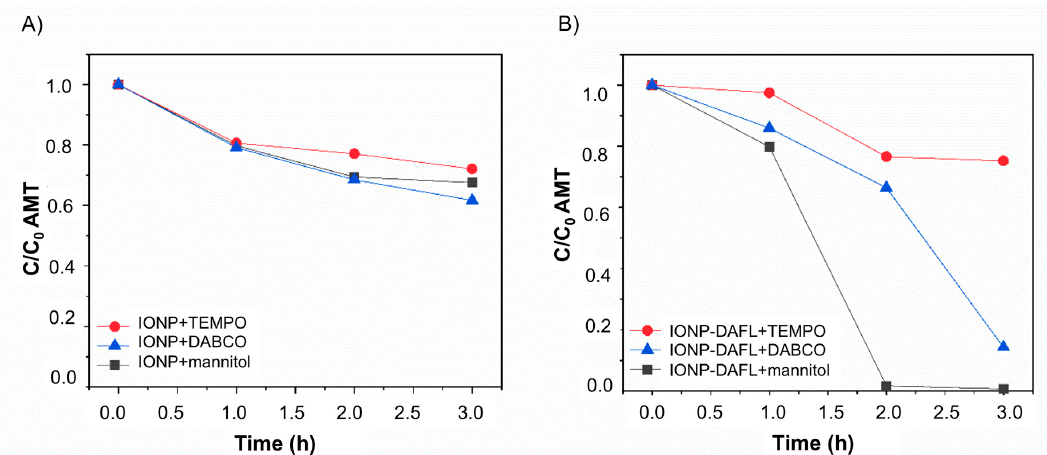
Figure 4. ( A ) The relative concentration of remaining AMT in solution (C / C 0 ) measured using UV-vis absorption spectroscopy ( λ max = 520 nm) after irradiation with 450 nm blue light for 3 h in the presence of ( A ) IONP or ( B ) IONP-DAFL and MES under an O 2 atmosphere with (2,2,6,6-tetramethylpiperidin-1-yl)oxidanyl (TEMPO), 1,4-diazabicyclo [2.2.2]octane (DABCO) and mannitol as reactive oxygen species (ROS)